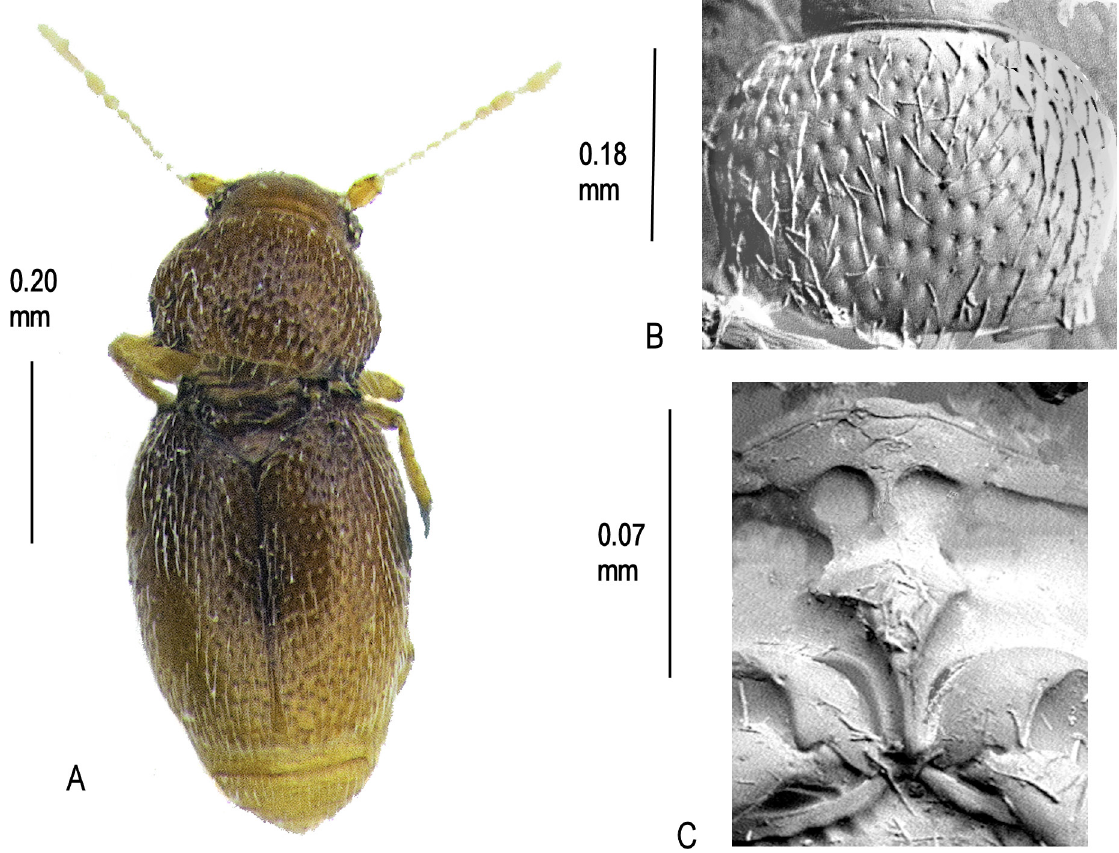
Fig. 59. Cissidium pauxillum Darby, 2019. A . Habitus. B . Pronotum, × 590. C . Mesoventrite showing median process of collar, mid-keel and keel,